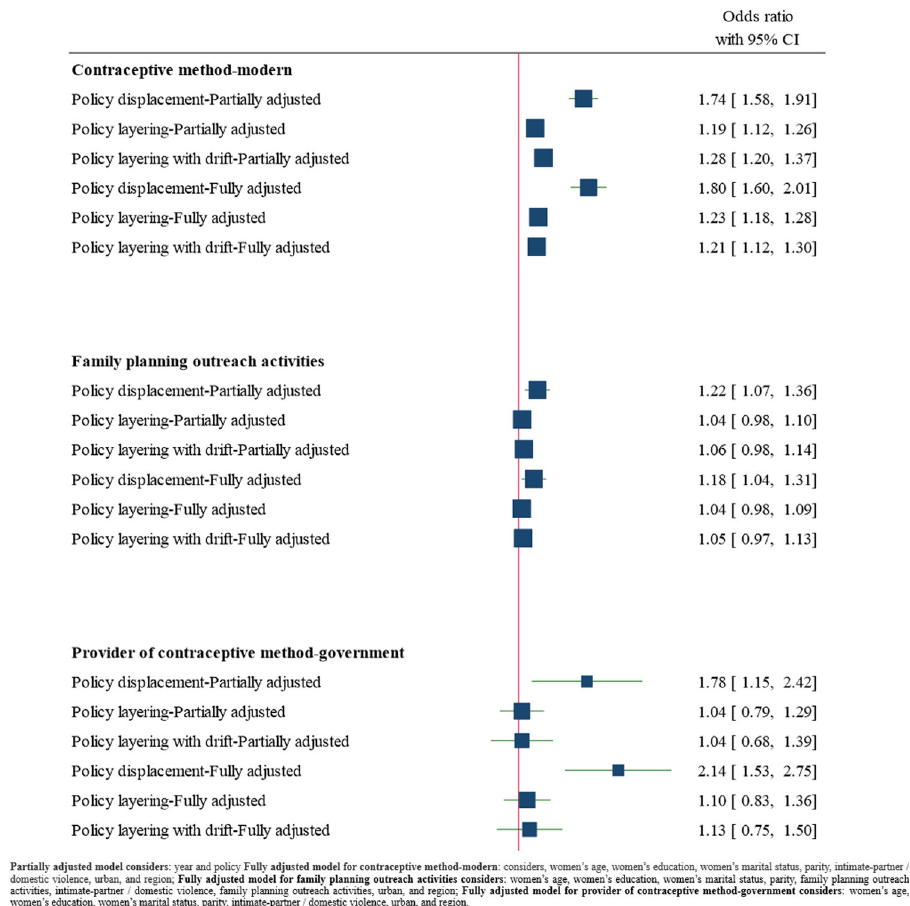
Fig. 5 Odds ratio of contraceptive method-modern, family planning outreach activities, and provider of contraceptive methods-government partially and fully adjusted (Colombia 2000 – 2016; N = 81,760; N = 49,493).